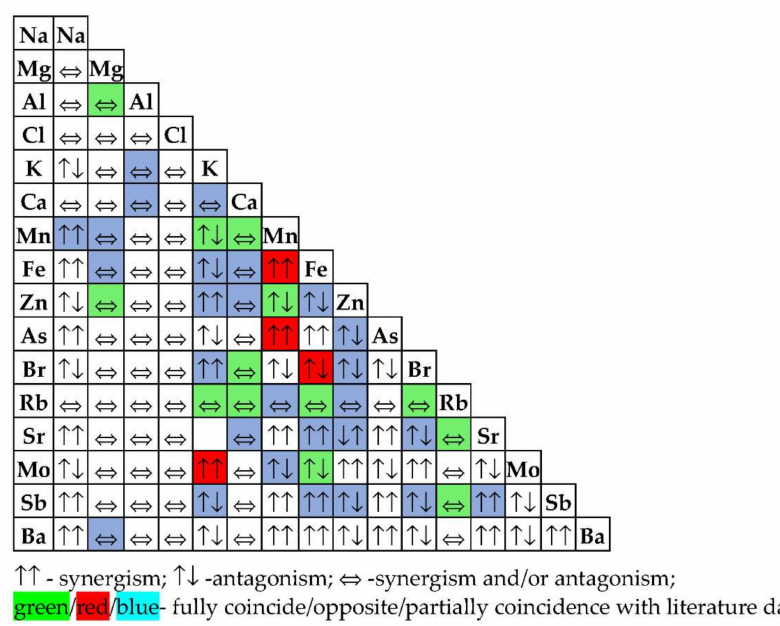
Figure 9. The comparison of our results with the data in the